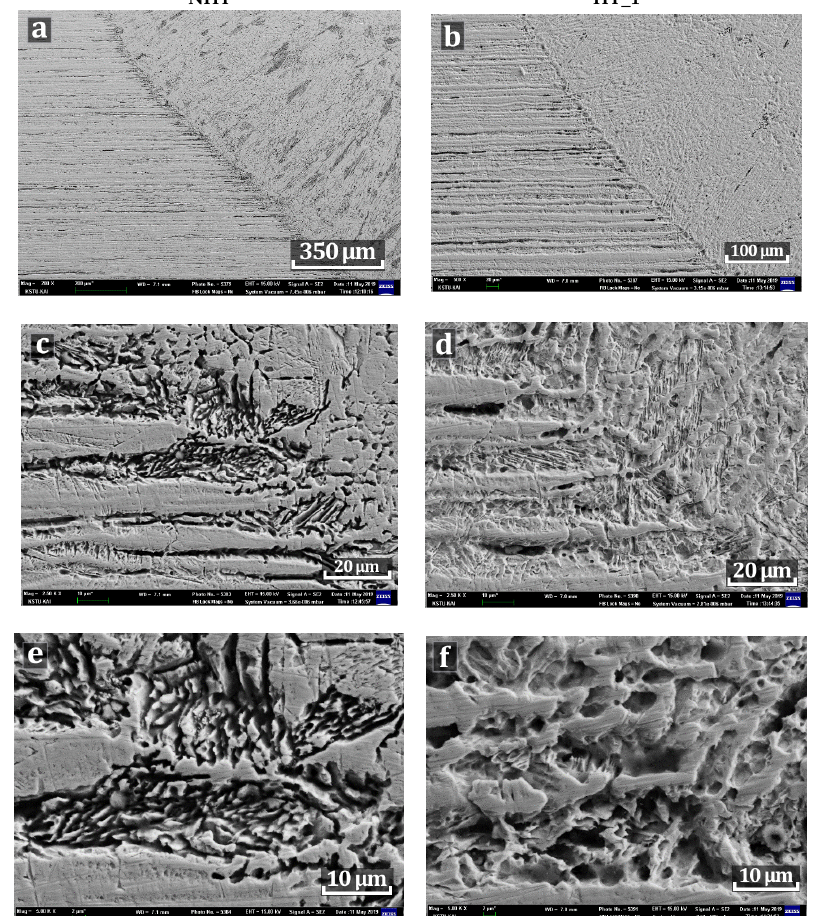
Figure 9. SEM images of the NHT and HT_1 samples. ( a ) magnification of 50 times of a NHT sample, ( b ) magnification of 50 times of a HT_1 sample, ( c ) magnification of 250 times of a NHT sample, ( d ) magnification of 250 times of a HT_1 sample, ( e ) magnification of 500 times of a NHT sample, ( f ) magnification of 500 times of a HT_1